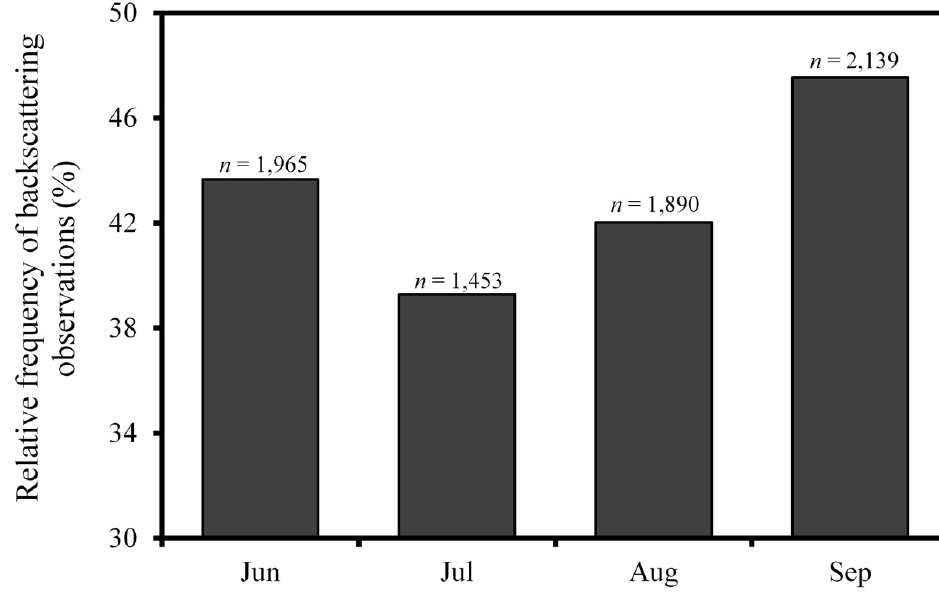
Figure 4. Dry season monthly variations in the relative frequency of pixels selected to compose the MOD13A2 product at the backscattering direction (RAA > 90 ◦ ). Comparatively, more BRDF hotspot observations ( n ) are registered from the beginning (June) to the end (September) of the dry season. Results refer to 2008 and 4500 pixels distributed over the entire Amazon region.